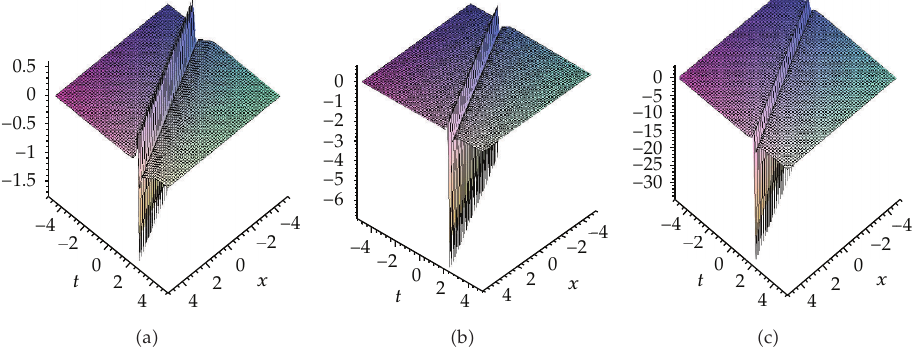
Figure 6: Evolutional behaviour of u 2 describes singular wave solution: (cid:3) a (cid:4) p (cid:7) 1 / 32 , q (cid:7) 1; (cid:3) b (cid:4) p (cid:7) 3 , q (cid:7) 1; (cid:3) c (cid:4) p (cid:7) 27 , q (cid:7)